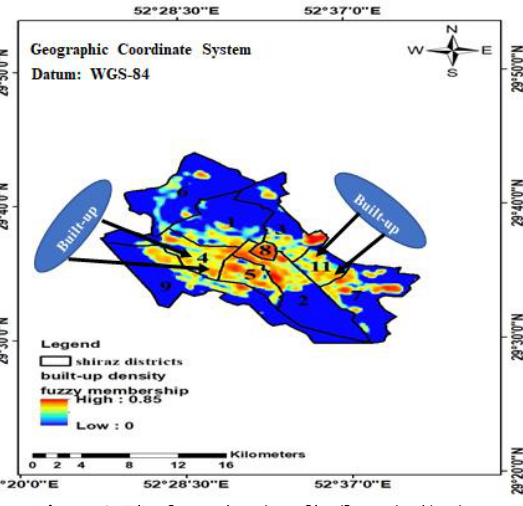
Figure 5. Agricultural lands and wells (green points) in district 7 and other districts